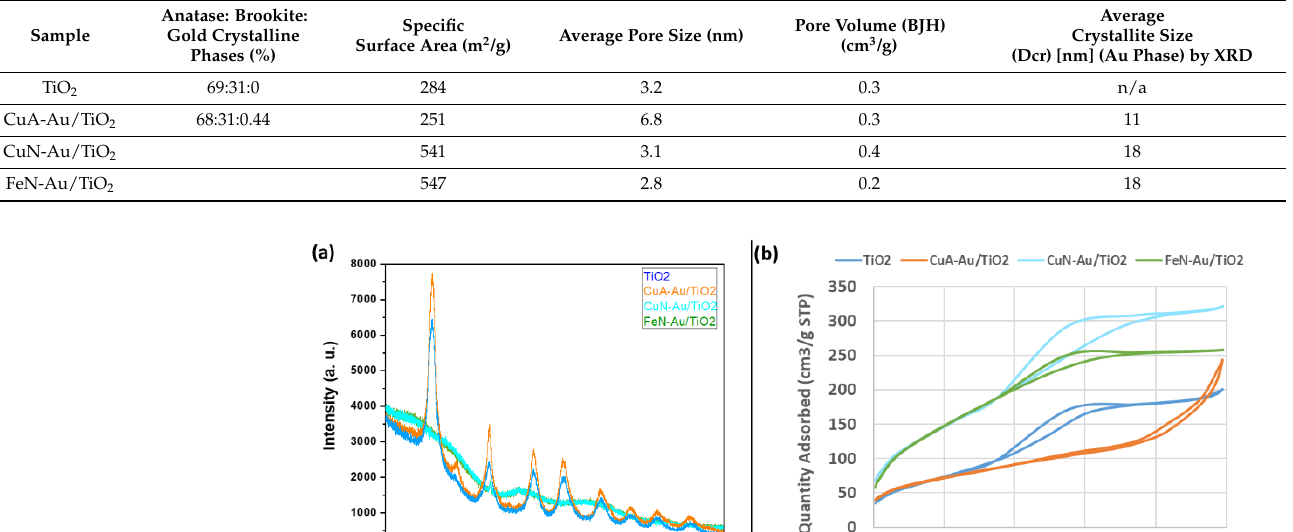
Figure 3. XRD patterns of different bimetallic synthesized catalysts ( a ) and N 2 sorption isotherm of bimetallic TiO 2 ( b ) compared to sol – gel-synthesized TiO 2 catalyst.